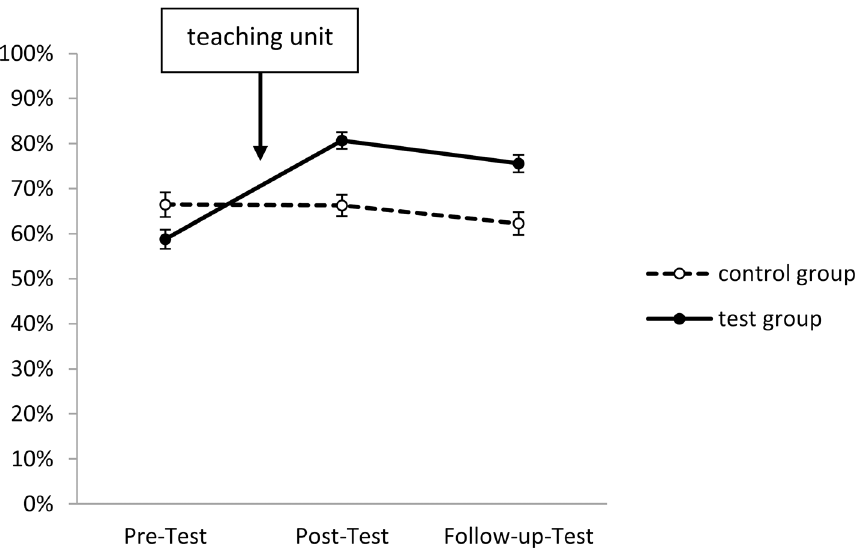
Fig 2. Development of daily life-related knowledge in test and control group (domain 2). Shown are solution rates (mean of all daily life-related items). For descriptives see S1 Table.